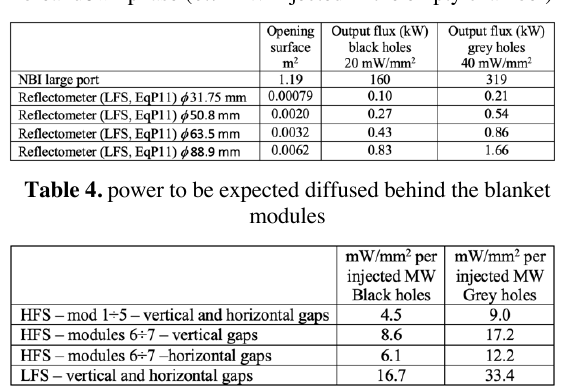
Table 3. expected output flux from some openings during the